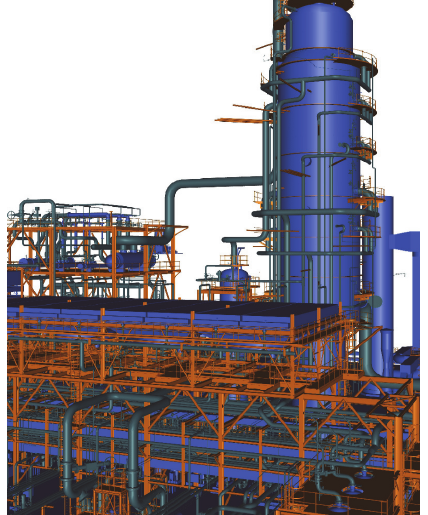
Fig. 8. Abadan Oil Refinery Co Phase 3 (3D Model) Fig. 9. Sample Piping Isometric Drawing (Isometric)